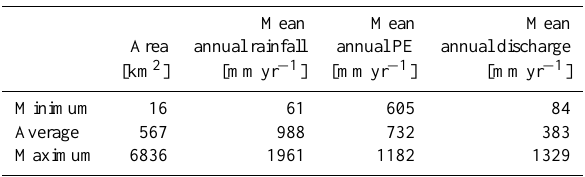
Table 1. Characteristics of the 237 French catchments used in this study.